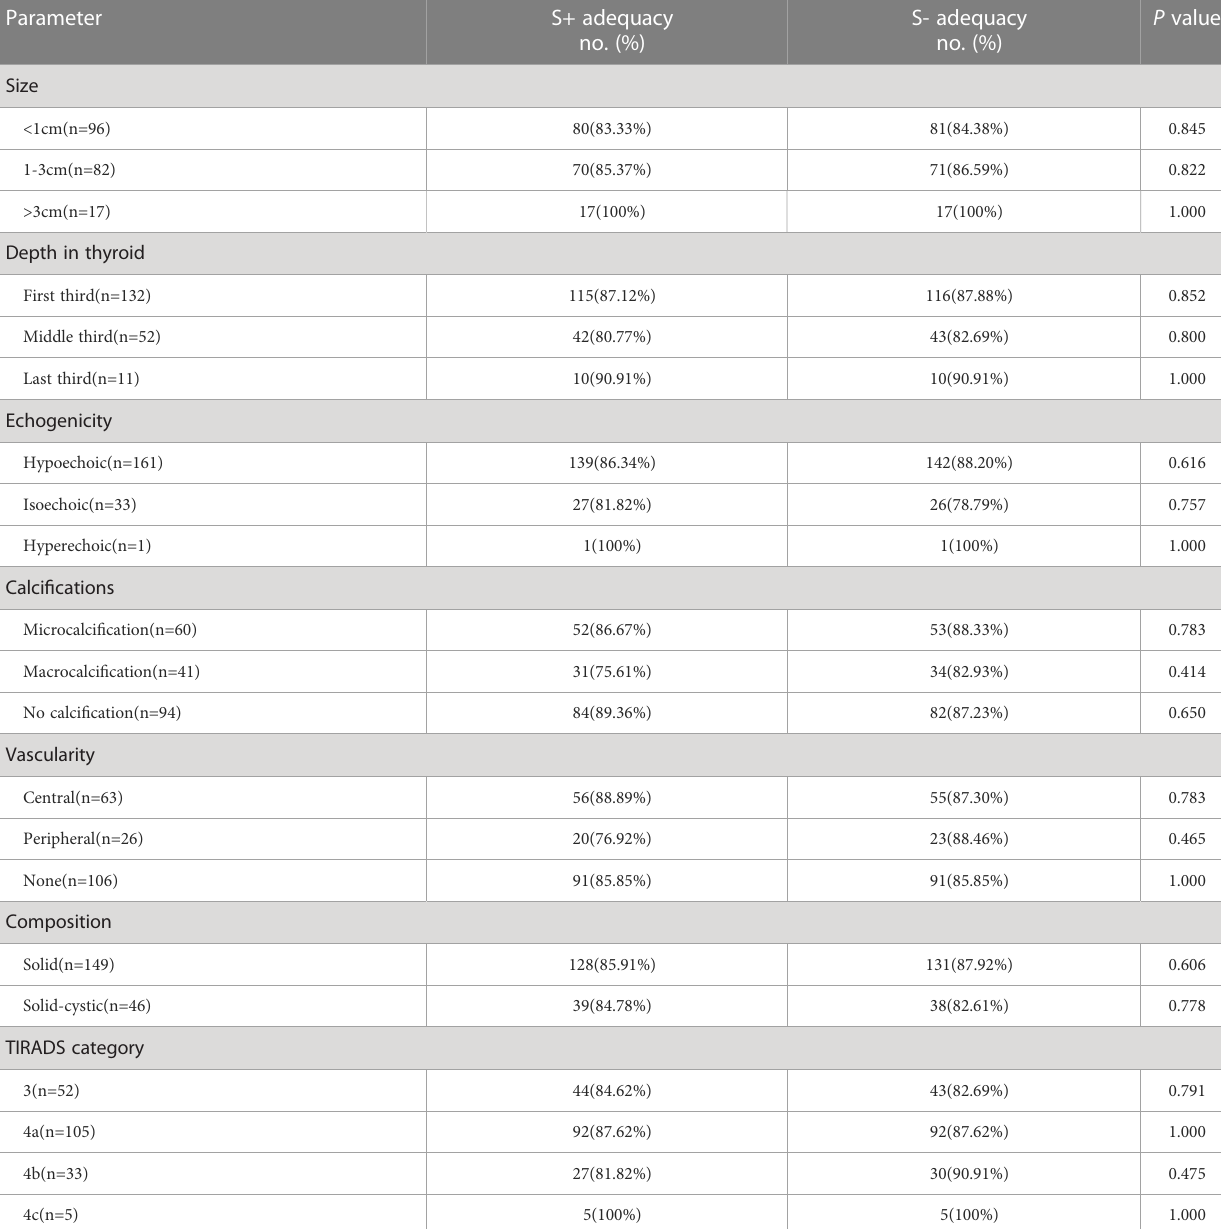
TABLE 2 Subgroup analysis of specimen adequacy obtained with and without stylet.